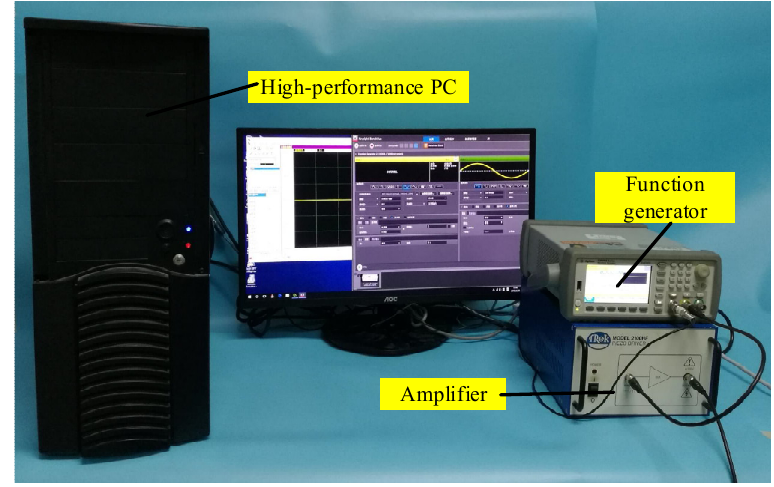
Figure 3. Instrumentation setup.